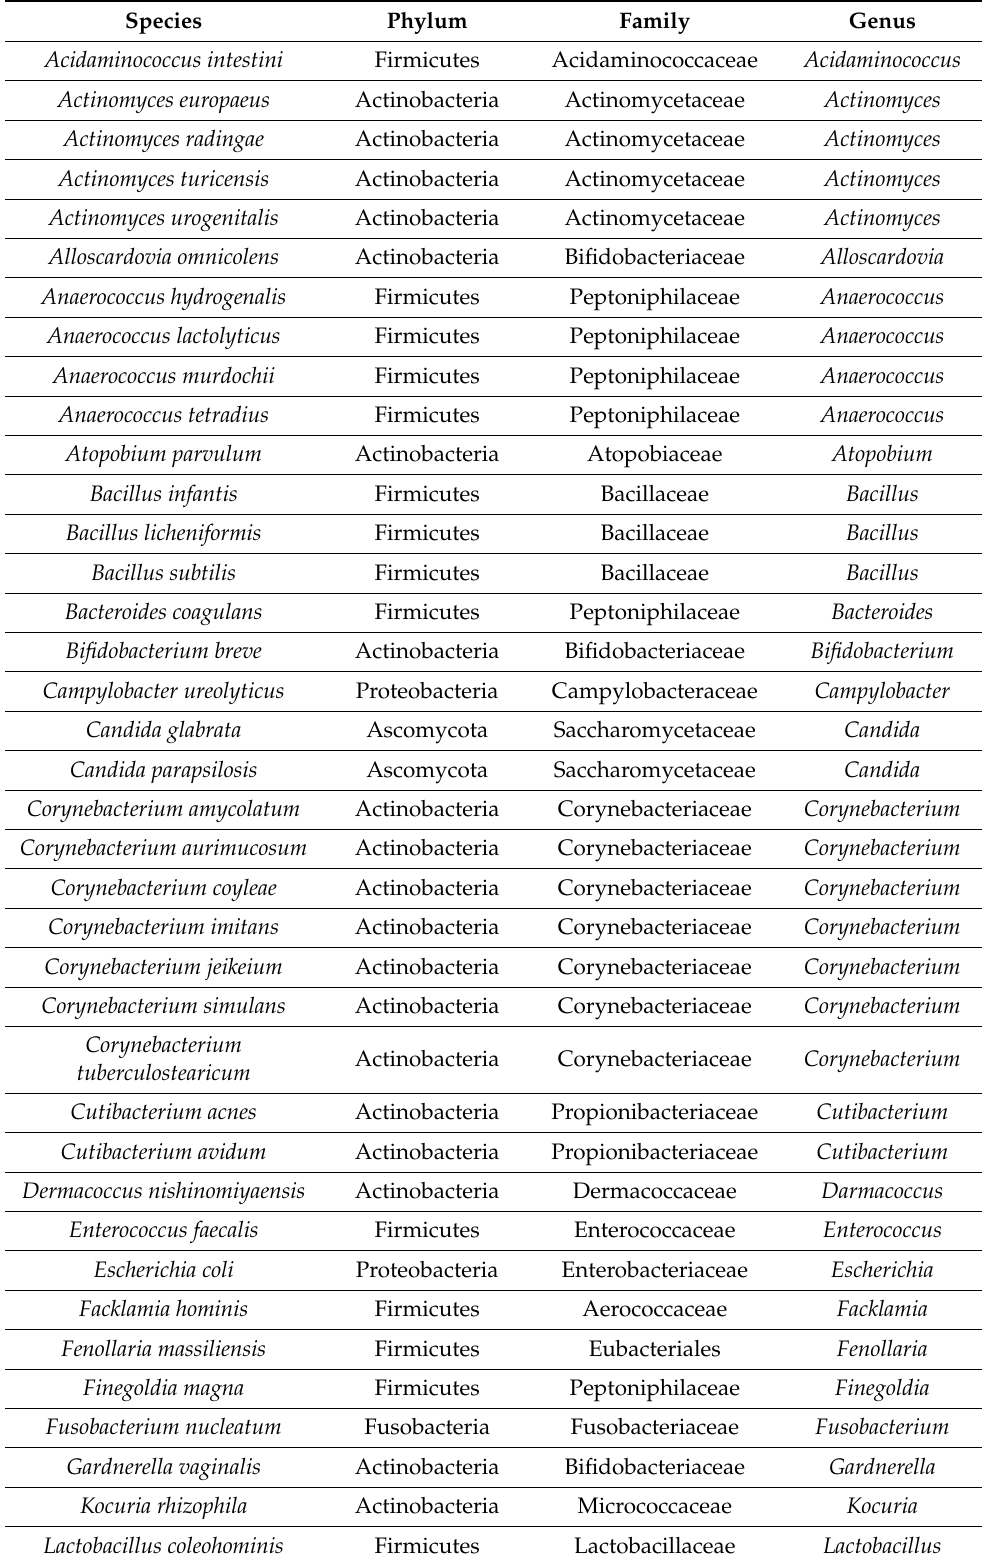
Table 2. Summary of the 85 different species found in the 10 endometrial biopsies. Detailed informa- tion per patient and per species available in Supplementary Table